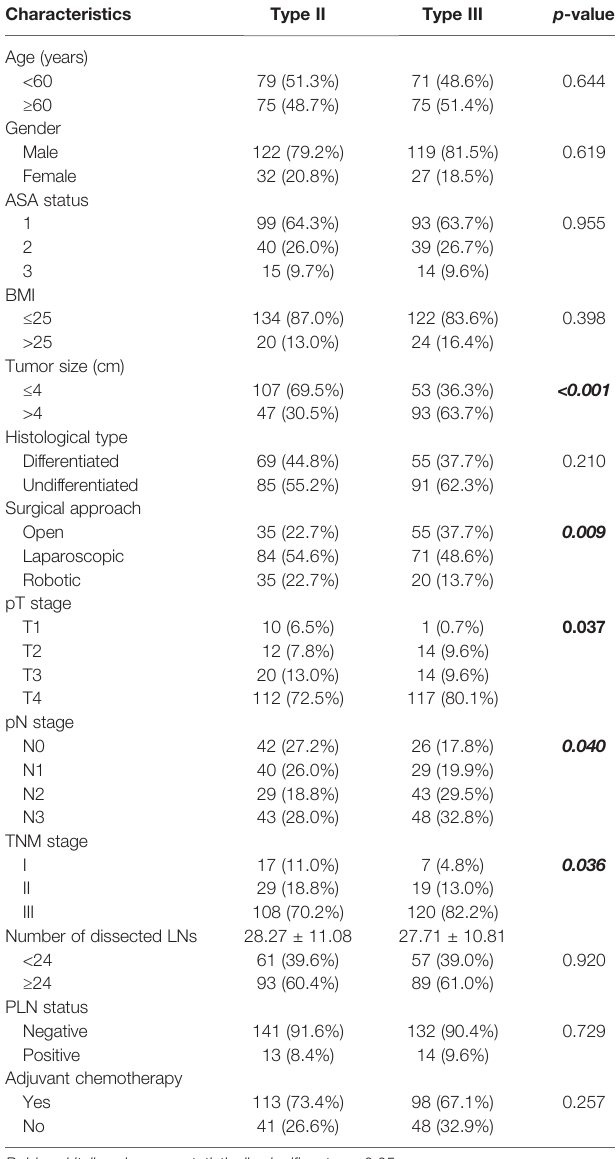
TABLE 1 | Clinicopathological features of the patients.